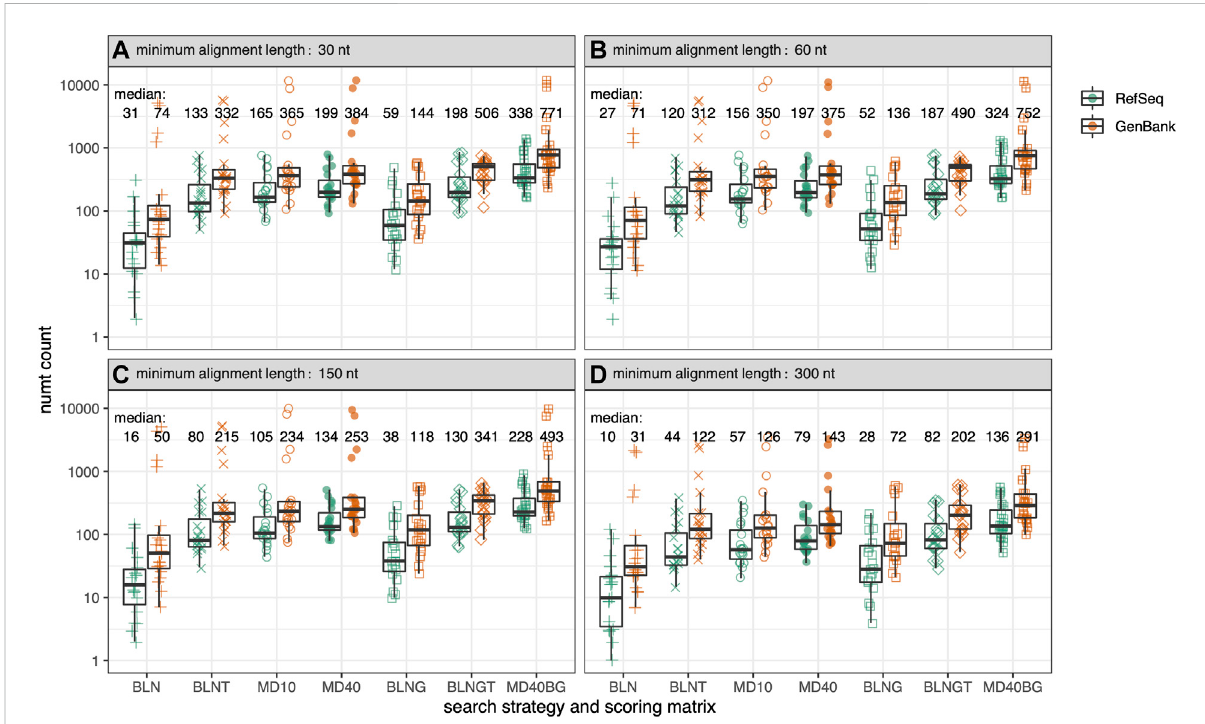
FIGURE 2 TotalnumtcountsforthegenomesinFigure1for7differentsimilaritysearchesasafunctionofalignmentlength.Withineachboxplot,thereare 39-symbolsforthe39-genomesdisplayedinFigure1color-codedbygenometype. (A) alignmentsatleast30 nt/10aa; (B) atleast60 nt/20aa; (C) at least 150 nt/50 aa; (D) at least 300 nt/100 aa. Median values are given for each type of similarity search with GenBank mtDNA genomes colored in orangeandRefSeqmtDNAgenomescoloredingreen.Thesymbolsforthe7differentsimilaritysearchesrunarethesameasinFigure1,andare labeled on the